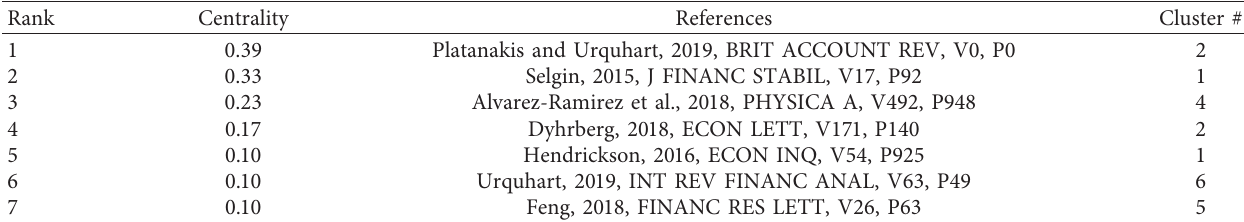
Table 3: Cited references with the highest betweenness centrality.